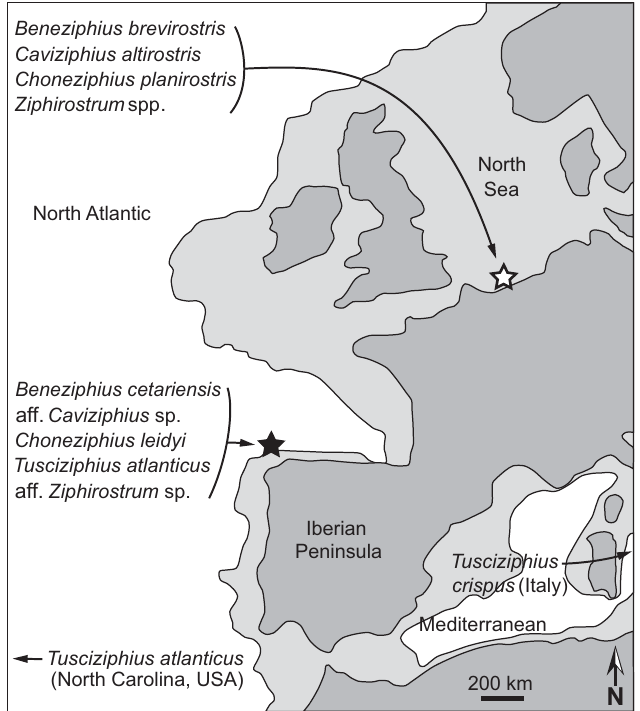
Fig. 7. Simplified palaeogeographic map of NW Europe, showing coastlines and the limits of the continental shelf (light grey) during the Serravallian– Tortonian (late middle to early late Miocene). Black star is the type local- ity of Beneziphius cetariensis sp. nov. (A Selva fishing ground) and white star is the type locality of B. brevirostris (Antwerp, Belgium). Other fos- sil ziphiid species are listed whose corresponding genera are found in at least two regions. Map redrawn from Scotese (2014). Note that the North Atlantic–Mediterranean connection was probably more complex than illus- trated in this schematic map (e.g., Kouwenhoven and van der Zwaan